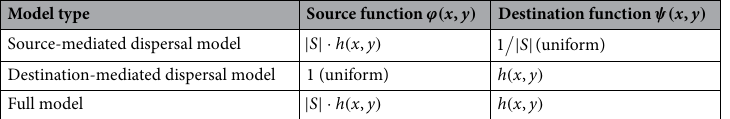
Table 2. Definitions of model